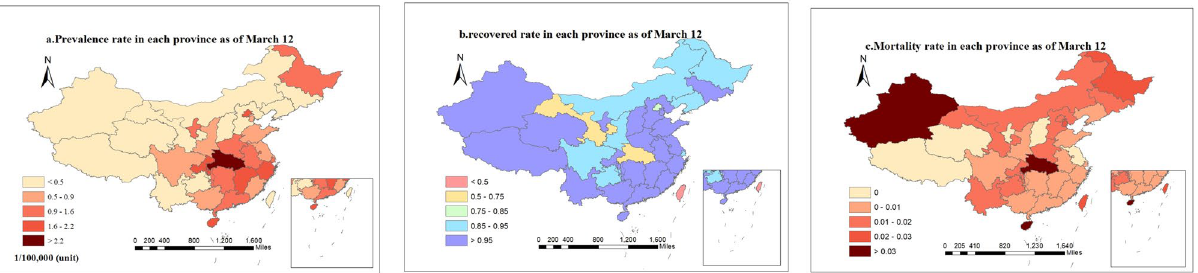
Figure 2. Distribution of the prevalence ( a ), recovered rate ( b ) and mortality rate ( c ) of COVID-19 in